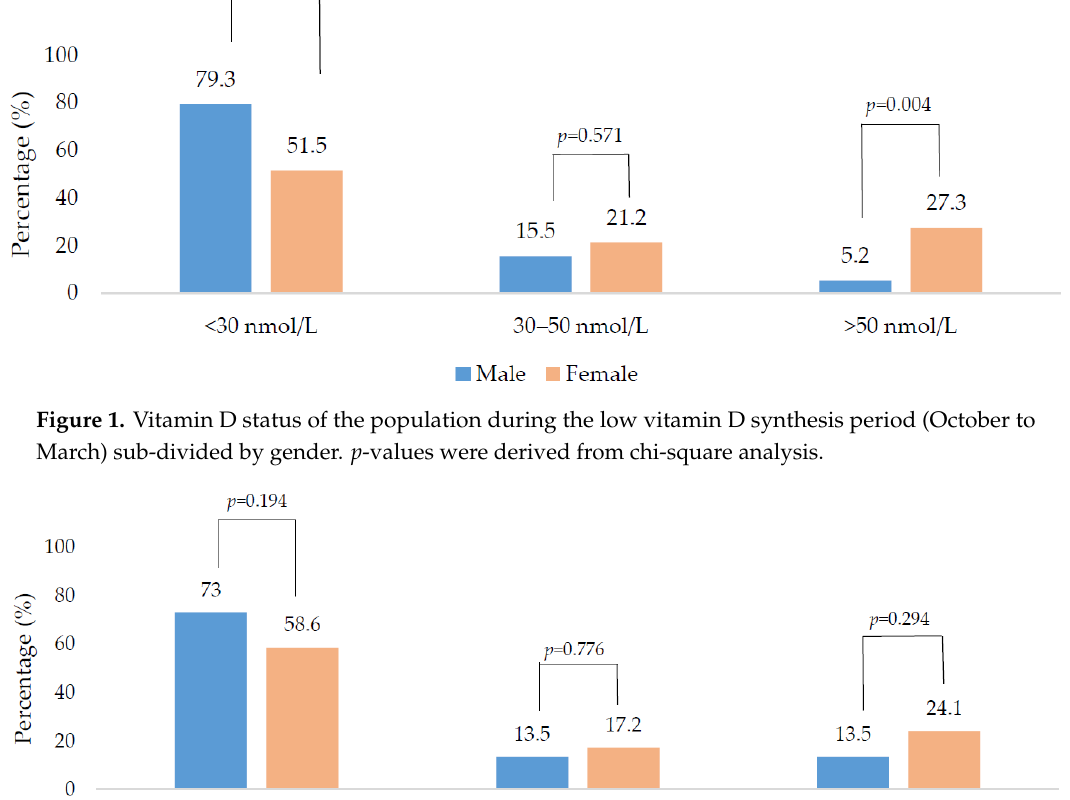
Figure 4. Vitamin D status of the population during the high vitamin D synthesis period (April to September) sub-divided by age group. Table 2. Bone marker concentrations of the participants by 25(OH)D status 1 . <30 nmol/L (Deficient)